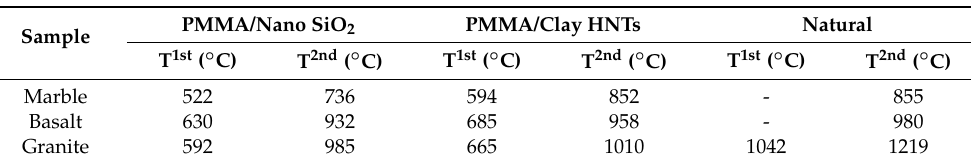
Polymers 2017 , 9 , x